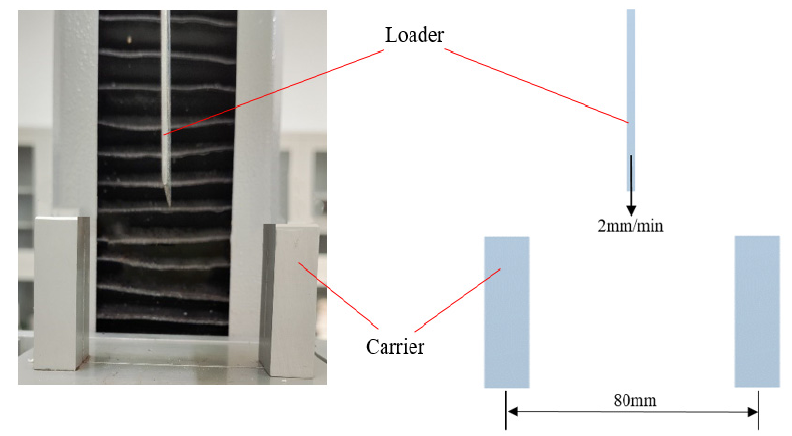
Figure 5. Bending test setup and geometric model.